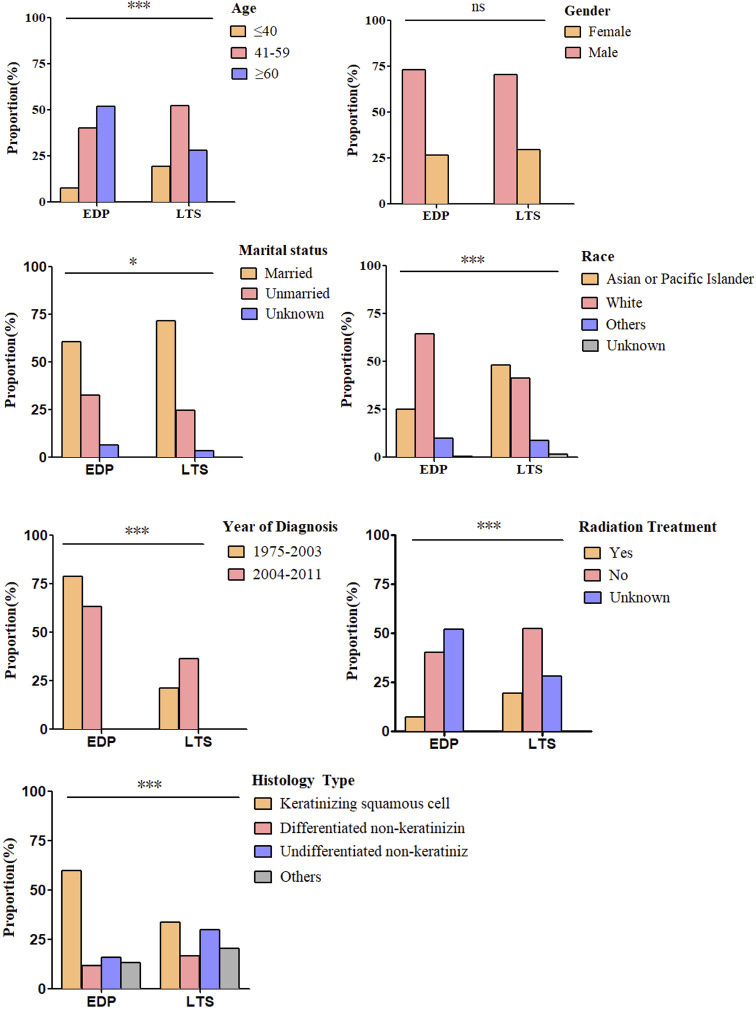
Differences in clinicopathological characteristics between EDP (N = 198) and LTS (N = 480) groups. Illustrated is the percentage of EDPs and LTSs for each included factor, including age (P < 0.001), sex (P = 0.26), marital status (P = 0.01), race (P < 0.001), year of diagnosis (P < 0.001), histology type (P < 0.001) and radiation treatment (P < 0.001). (ns, no significance. *P < 0.05, ***P < 0.001). The analysis was conducted using the Pearson X2 test.